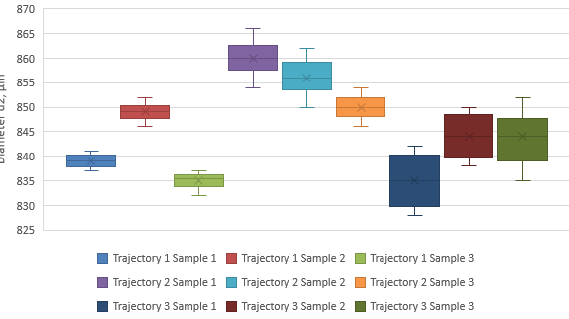
Figure 14: Statistical analysis of d2 diameter value measurements for all trajectories.